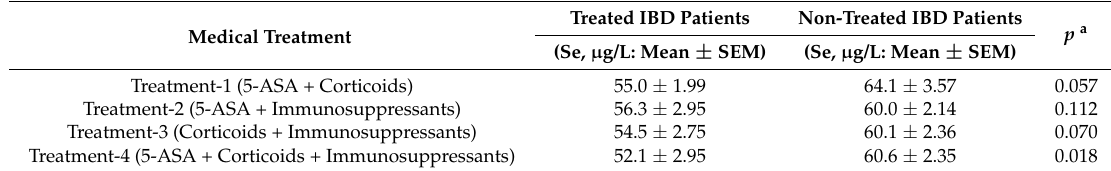
Table 8. Serum Se Concentrations of IBD patients as a function of medical treatment.